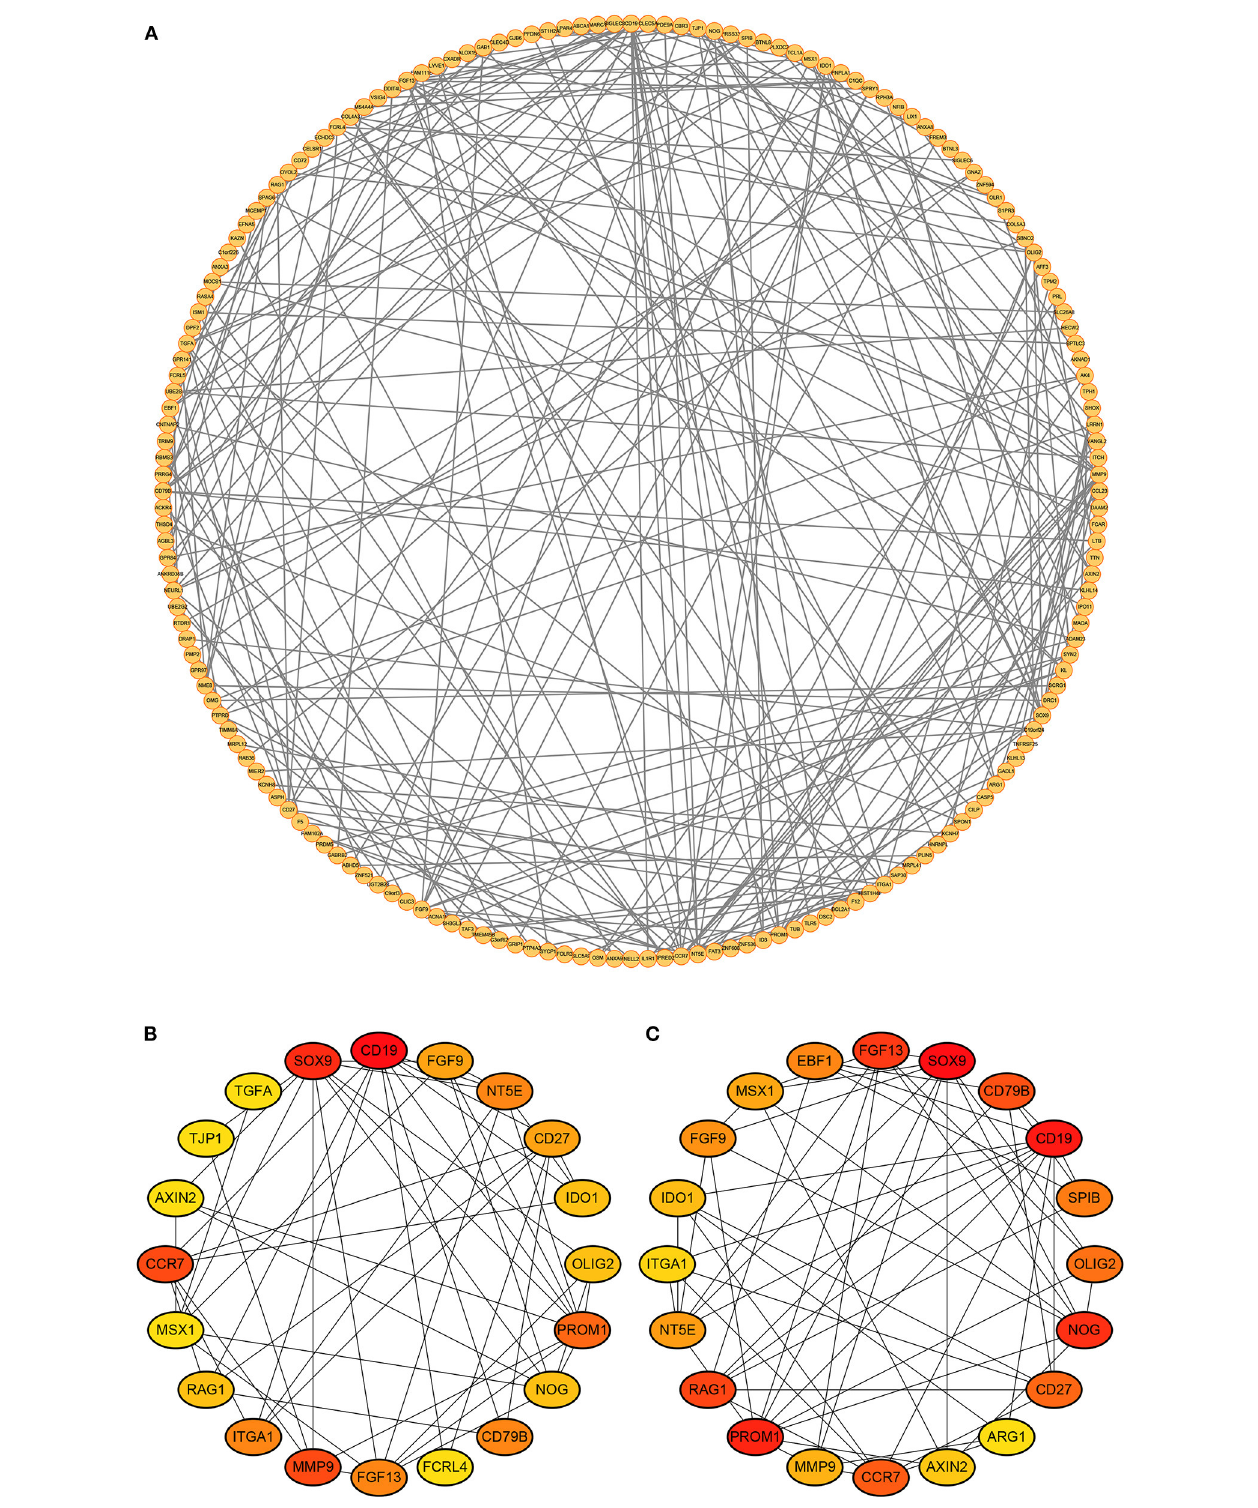
FIGURE 4 | Protein-protein interactions network. (A) The PPI network of DEmRNAs. (B) Top 20 genes ranked by Degree score. (C) Top 20 genes ranked by MCC score.